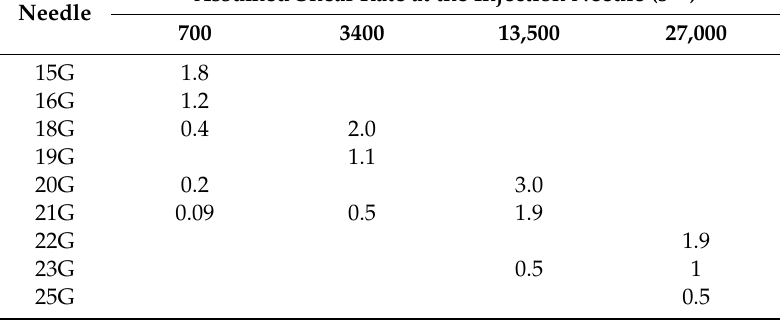
Table 2. The set value of the crosshead speed (mm · s − 1 ) in order to obtain the assumed shear speed in the needle. Assumed Shear Rate at the Injection Needle (s − 1 Needle